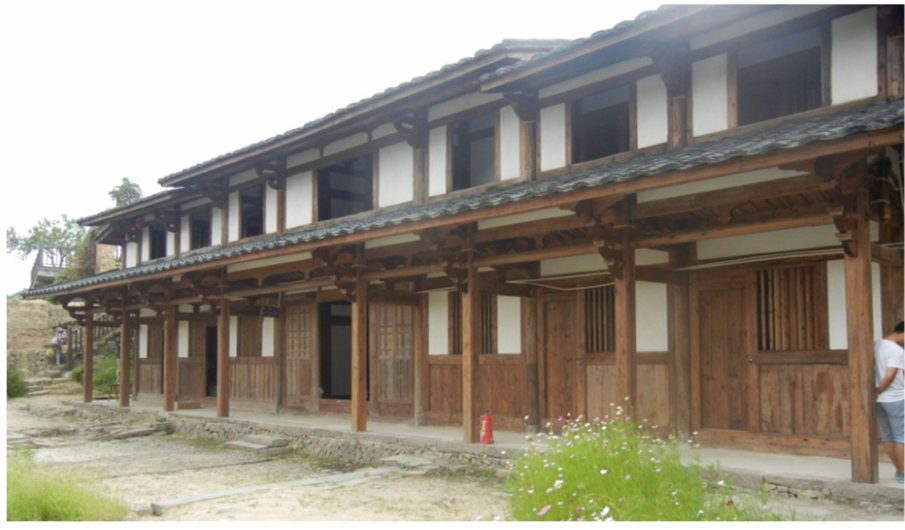
Figure 1. Seven Literary World.